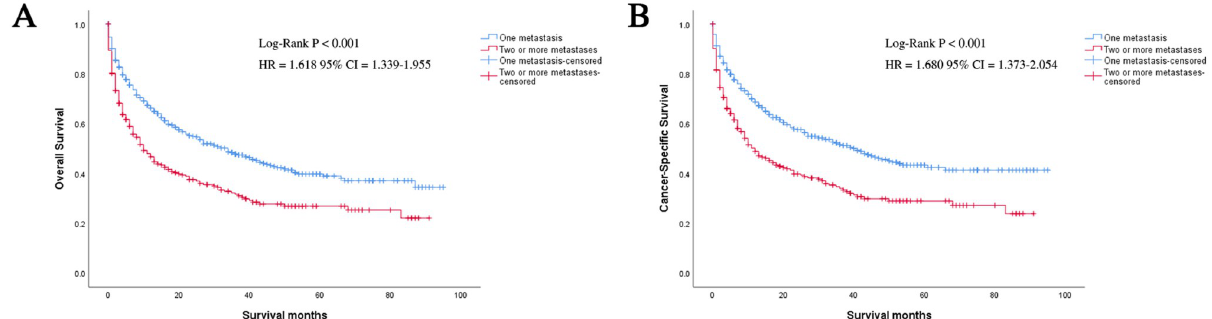
Fig 2. Kaplan-Meier curves of OS and CSS according to the number of metastatic sites. Patients in one metastasis had significantly better survival both in OS and CSS; (a) OS; (b) CSS; OS, overall survival; CSS, cancer-specific survival; HR, hazard ratio; CI, confidence interval.